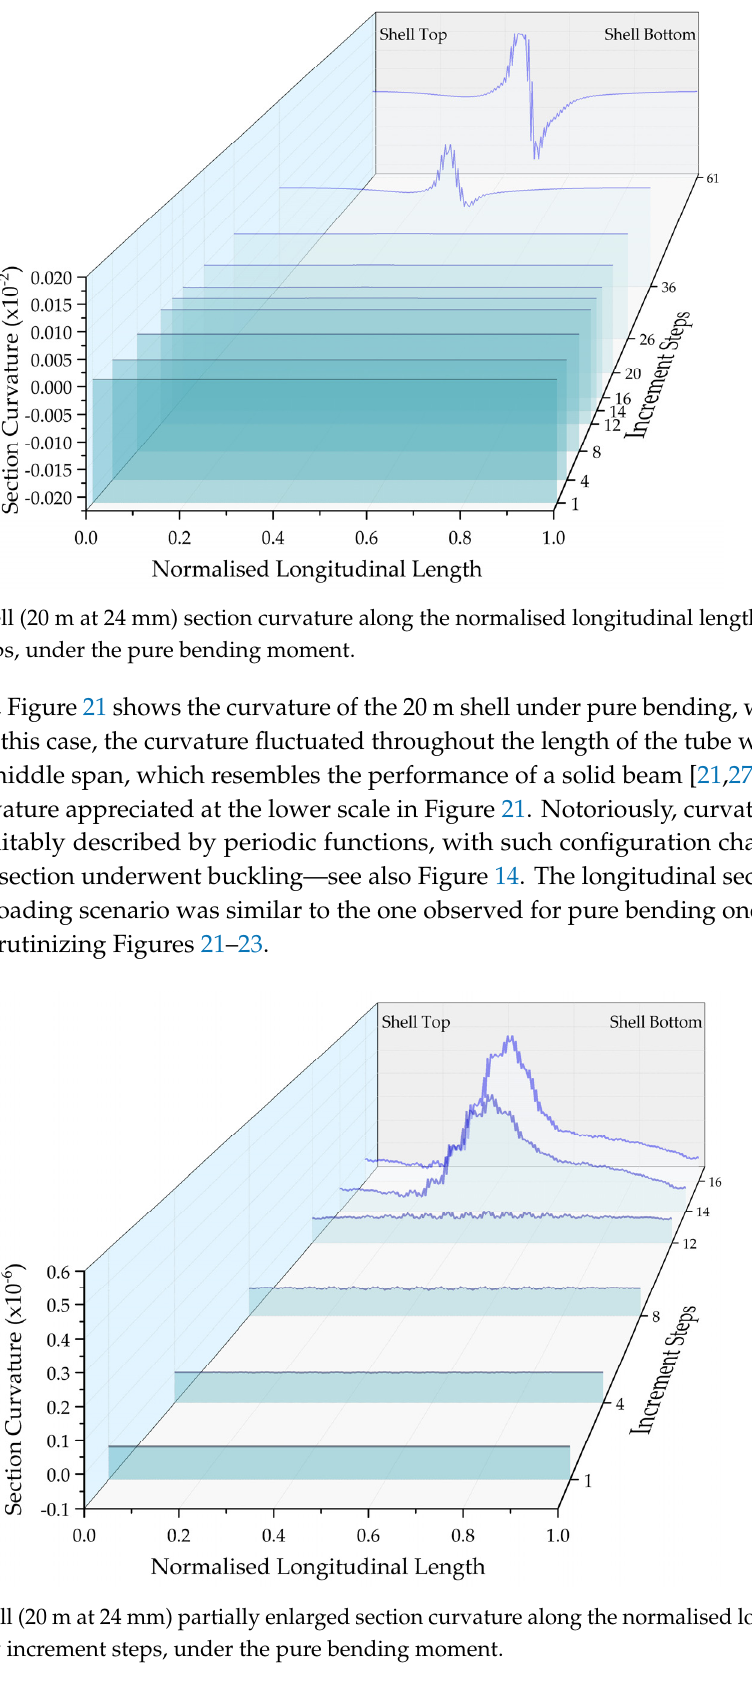
Figure 20. Shell (9 m at 24 mm) strain energy magnitudes along the normalised longitudinal length at typical increment steps, under the pure bending moment.